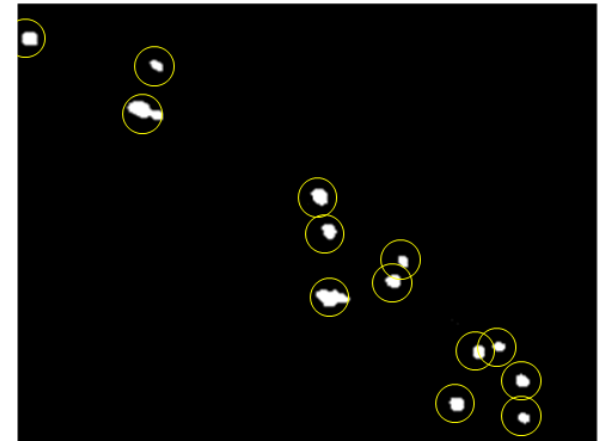
Figure 5: Result of vehicles detected from MS-1 image